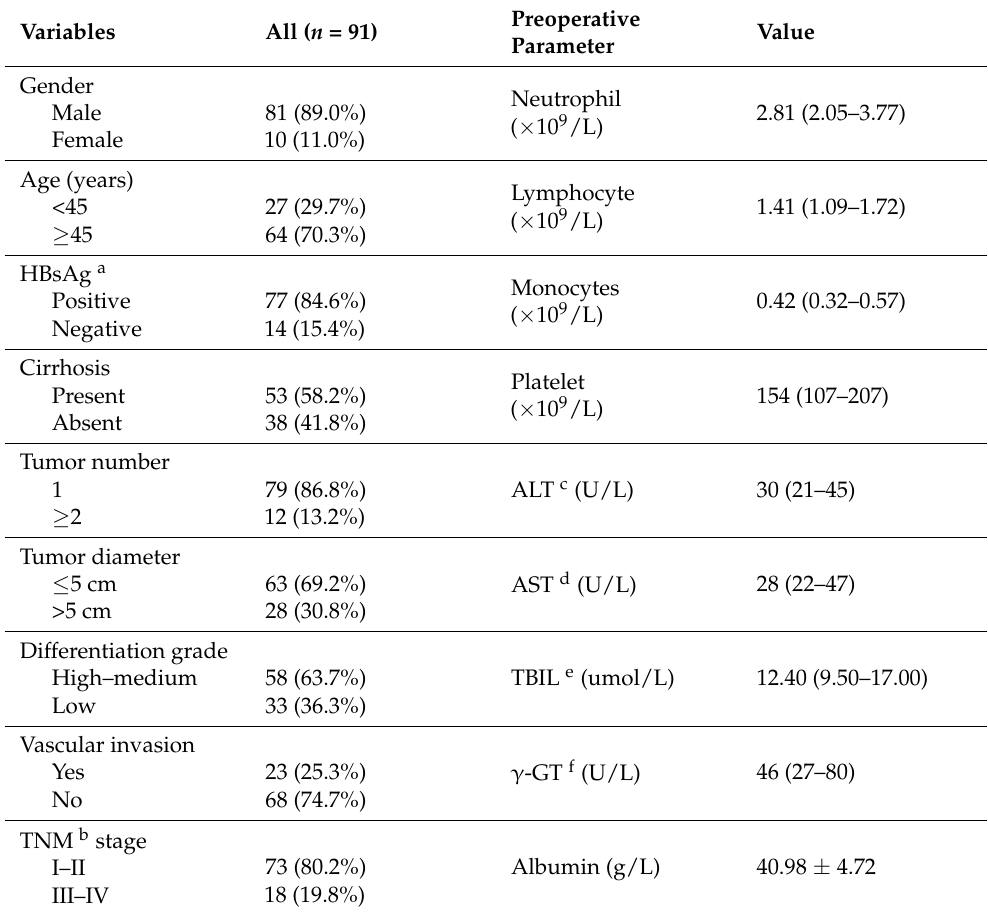
Table 1. Baseline clinicopathological features of the